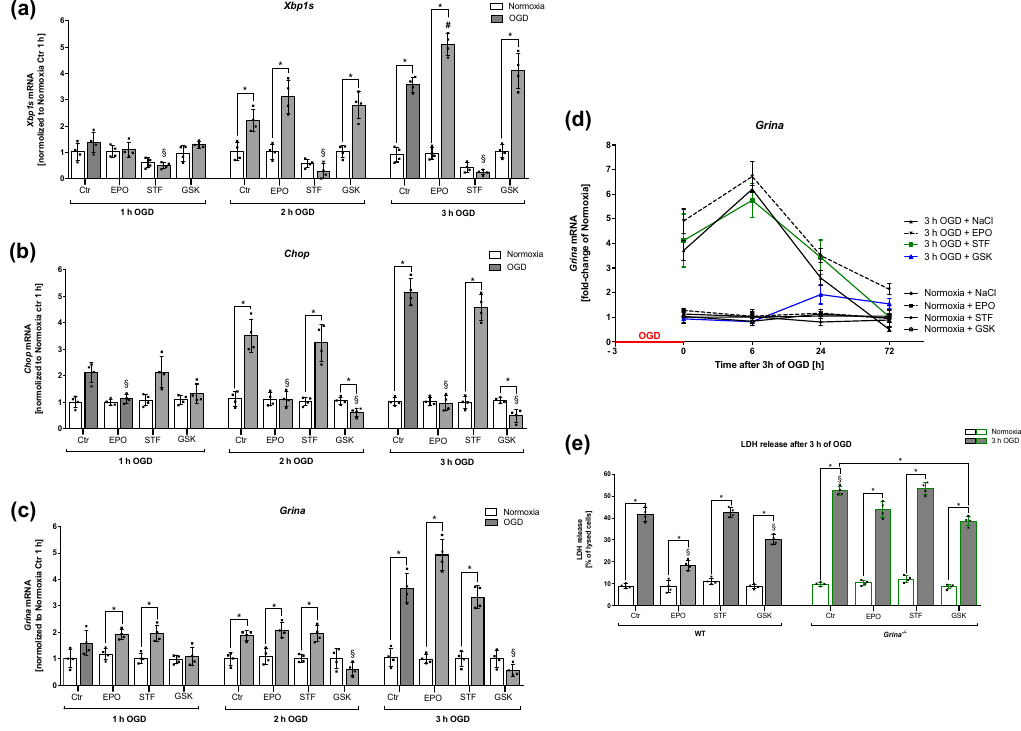
Figure 7. EPO administration and inhibition of the PERK arm of UPR reduced cell deatand regulated Grina mRNA levels after OGD/reoxyginationTreatment with PERK-inhibitor GSK [100 nM], IRE1 α - inhibitor STF ( 30 μ M), EPO (1 U/mL) or corresponding controls (NaCl/DMSO) was performed 1 h prior to either 1 h, 2 h or 3 h of OGD in wildtype murine cortical cells. The mRNA levels of Xbp1s ( a ), Chop ( b ) and Grina ( c ) after 1 h, 2 and 3 h of OGD are shown. ( d ) The impact of STF, GSK and EPO on Grina mRNA levels in wildtype primary murine cortical cells after 3 h of OGD followed by 6 h, 24 and 72 h of reperfusion is shown. ( e ) LDH release in Grina − / − and wildtype primary murine cortical cells was determined after 3 h of OGD. Bars represent means ± SD. n = 4 individual cell culture preperations from mice pups (P0–P2) of all genotypes and treatment groups. * p < 0.05 intergroup or treatment comparison, # p < 0.05 EPO treatment compared to the vehicle group, § p < 0.05 compared to wildtype control (Ctr).